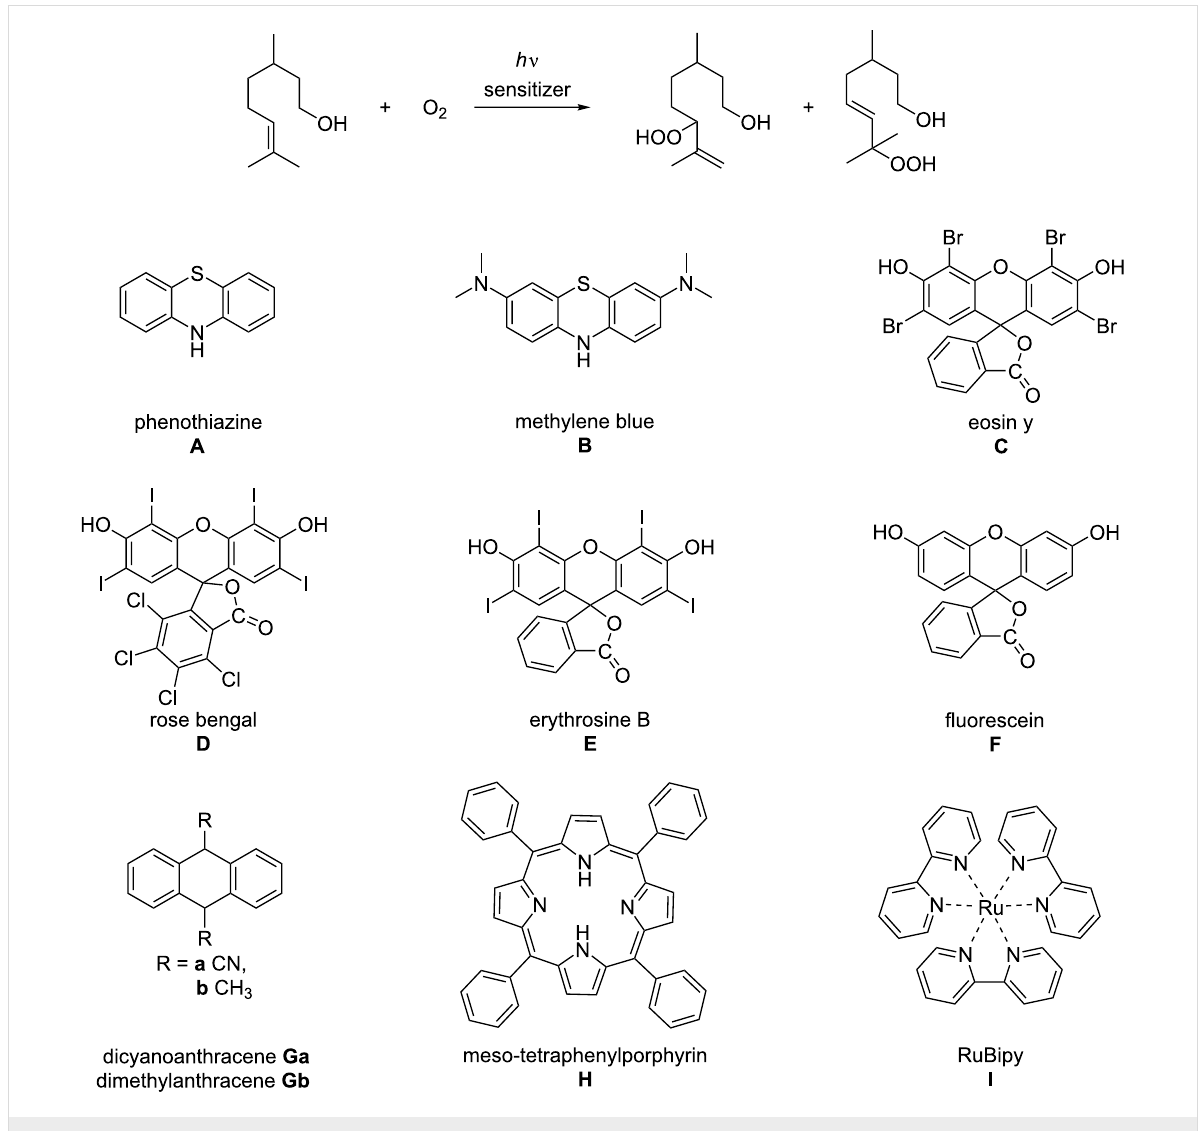
Scheme 1: Photocatalysts A – I screened for the oxidation of citronellol.